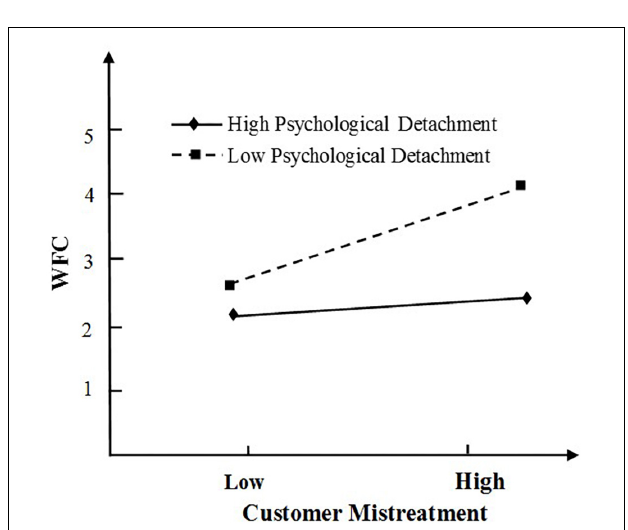
FIGURE 2 | Interaction between customer mistreatment and psychological detachment on WFC.